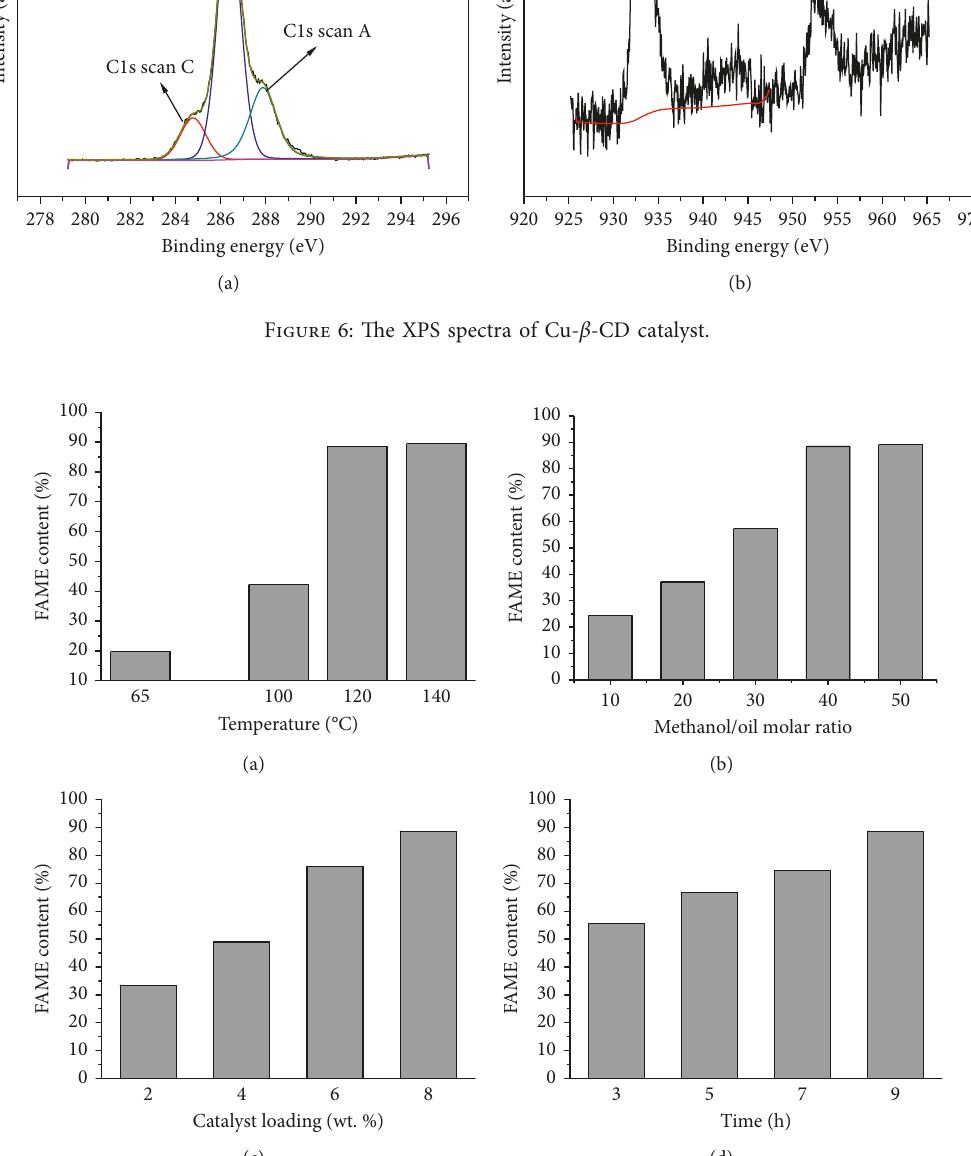
Figure 7: The effect of single factor on the FAME content. (a) Effect of temperature on FAME content (methanol/oil molar ratio CA 8 wt.%, t 9h). (b) Effect of methanol/oil molar ratio on FAME content (CA (cid:30) (cid:30) on FAME content (methanol/oil molar